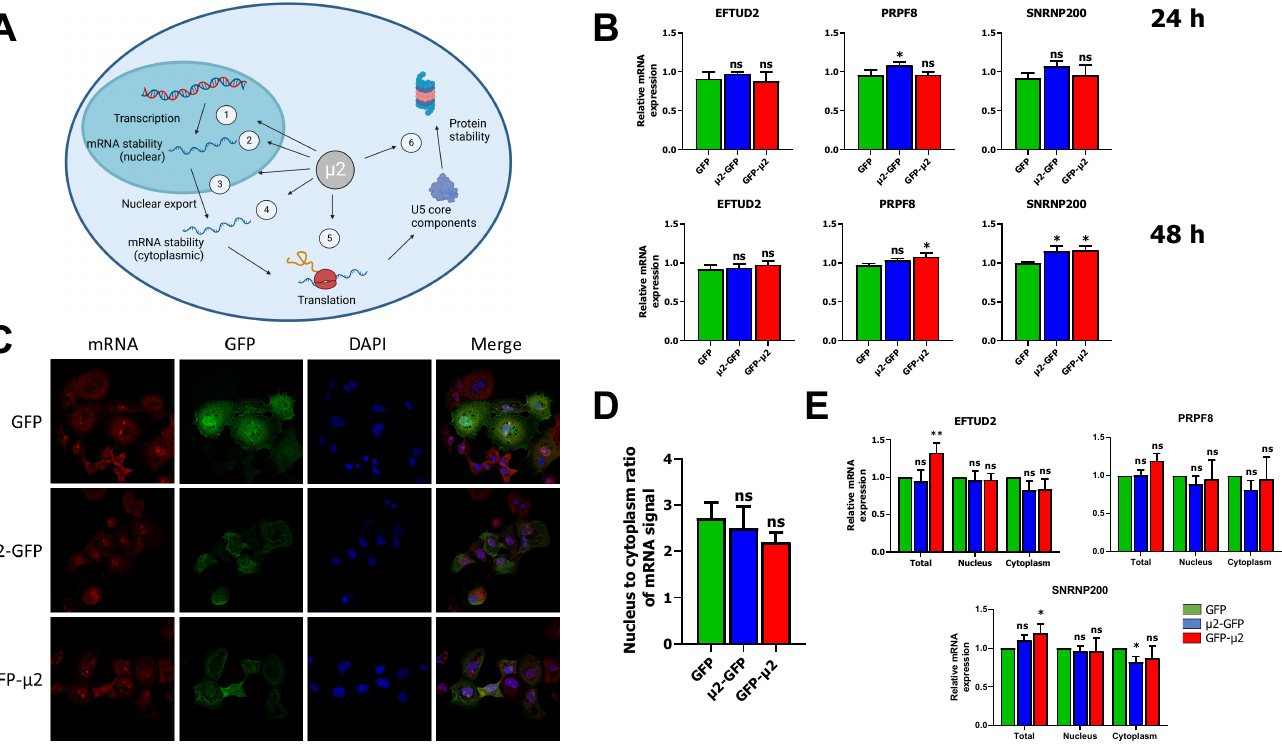
Figure 1. The µ 2 protein does not impact EFTUD2, PRPF8, and SNRNP200 mRNA levels or nuclear export: ( A ) outline of the different mechanisms by which the µ 2 protein could alter the renewal and proteins levels of U5 snRNP core components. Created with Biorender.com; ( B ) relative mRNA levels determined by qPCR for EFTUD2, PRPF8, and SNRNP200 in GFP or µ 2-GFP expressing cells. RNA was harvested with Qiazol at 24 h or 48 h post-transfection, reverse-transcribed, and subjected to qPCR with MRPL19, PUM1, and YWHAZ used as housekeeping genes. The first replicate in the GFP control condition was fixed at 1, and the relative mRNA expression was calculated for all other samples relative to that one. n = 3, biological replicates, one-way ANOVA with Dunnett’s multiple comparisons test against the GFP alone condition (ns, p > 0.05; *, p ≤ 0.05); ( C ) COS-7 cells were transfected for 24 h and mRNA was labelled using a 5’Cy oligo (dT) using standard FISH procedure, as described in Materials and Methods. Nuclei were labelled using DAPI, and GFP signal was imaged at 488 nm; ( D ) quantification of mRNA signal was performed with Cell Profiler. The mRNA signal from cells expressing GFP or µ 2-GFP (between 15 and 21 cells from three different fields) was quantified for each condition and is shown. One-way ANOVA with Dunnett’s multiple comparisons test against the GFP alone condition (ns, p > 0.05); and ( E ) relative mRNA level determined by qPCR for EFTUD2, PRPF8, and SNRNP200 in total, nuclear, and cytoplasmic fractions from GFP or µ 2-GFP expressing cells at 24 h post-transfection. Cells were fractionated, RNA was isolated from total, nuclear, and cytoplasmic fractions with Qiazol, reverse-transcribed and subjected to qPCR with MRPL19, 5.8S, and YWHAZ as housekeeping genes. The relative expression is calculated against the GFP condition for each fraction (total, nuclear, cytoplasmic) in each replicate. n = 3, biological replicates, two-way ANOVA with Dunnett’s multiple comparisons test against the GFP alone condition for each fraction (ns, p > 0.05; *, p ≤ 0.05; **, p ≤ 0.01). Results presented are mean ± standard